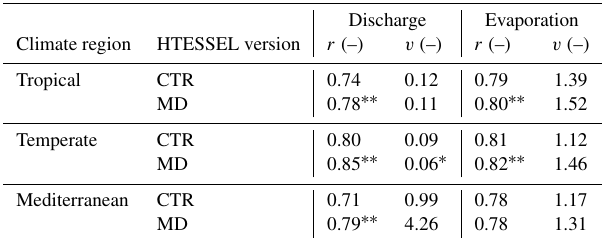
Table 4. Model performance parameters of interannual monthly discharge ( Q ) and evaporation ( E ) anomalies (1975–2010), with r representing Pearson correlation and v = (1 − α ) 2 variability (where α = σ mod /σ obs ), in tropical, temperate and Mediterranean climate regions for the HTESSEL CTR and MD versions (catchment aver- ages). Modeled Q is compared to station observations and modeled E to FLUXCOM-WB (Eq. 1). For r , a value of 1 represents a per- fect model; for v a value of 0 represents a perfect model. The sig- nificance test of the MD improvements compared to CTR is repre- sented by ∗∗ (passing the 5% level) and ∗ (passing the 10% level). Values of r and α for the individual catchments and p values of improvement are shown in Tables S5 ( Q ) and S6 ( E